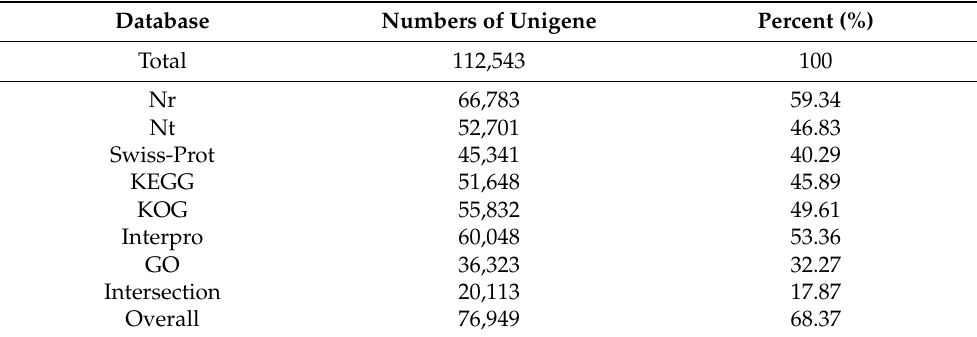
Table A5. Annotation results in different databases.